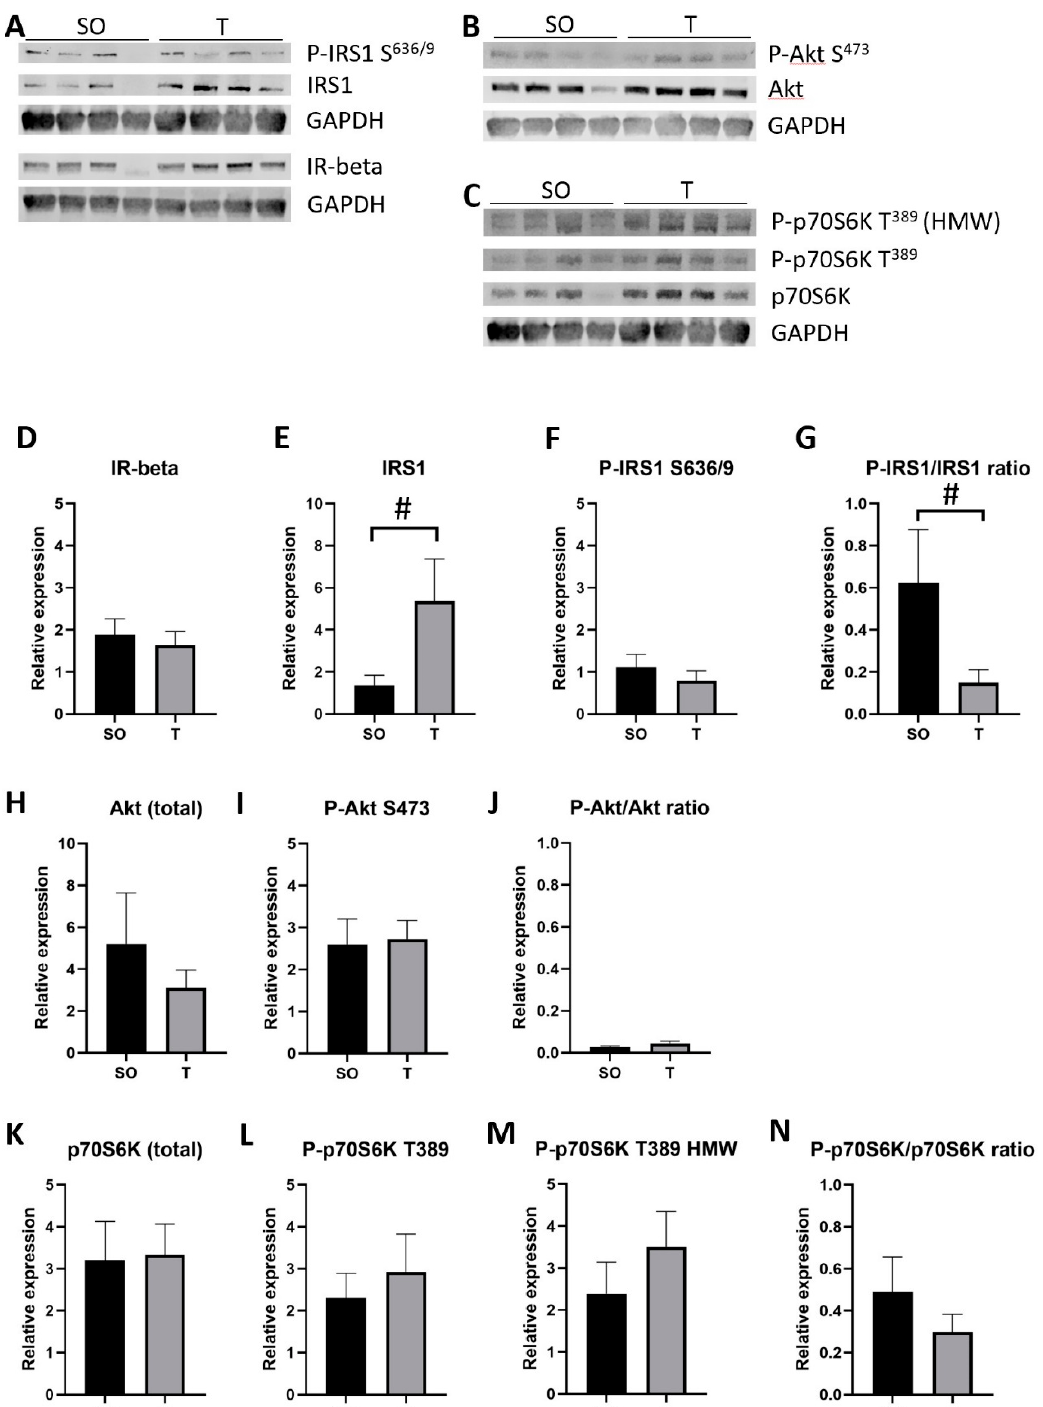
Figure 10. Greater IRS1 protein expression and lower Ser 636 / 9 phosphorylated IRS1 to IRS1 ratio in PNA tibialis anterior muscle. Tibialis anterior muscles from 16-week-old rats were homogenized on ice in bu ff er containing protease and phosphatase inhibitors. ( A – C ) Homogenates (30 µ g) were separated by SDS-PAGE prior to transfer to nitrocellulose for immunoblot analysis of proteins. ( D – N ) Band intensity was quantified using ImageStudio Lite software (Version 5.2), and data were analyzed using unpaired t tests. Expression of total IRS1 protein trended higher in TA from PNA rats ( A , E ; # p = 0.0911); Ser 636 / 9 phosphorylated IRS1 expression was comparable, resulting in a trend toward decreased P-IRS1 to total IRS1 ratio in TA from PNA rats ( G ; # p = 0.0754). Means with SD are